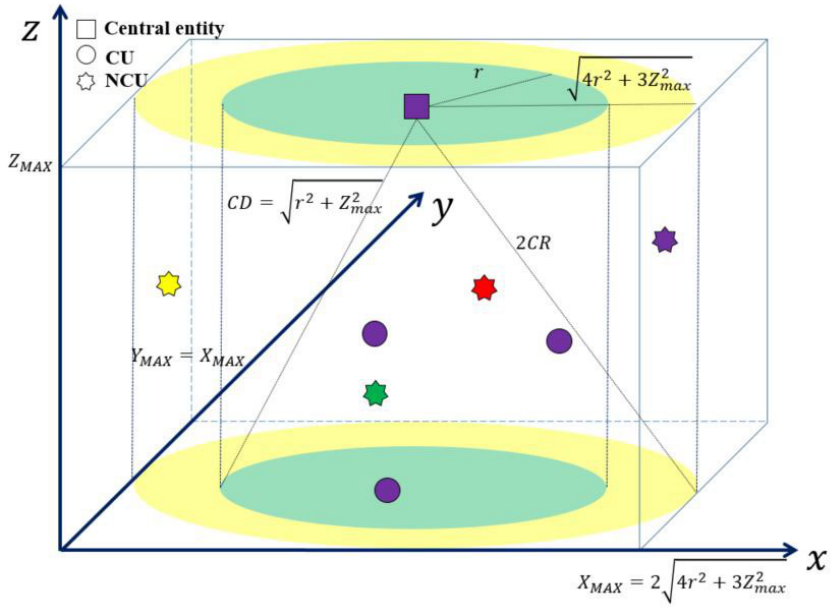
Figure 1. The topology of a centralized UCAN.